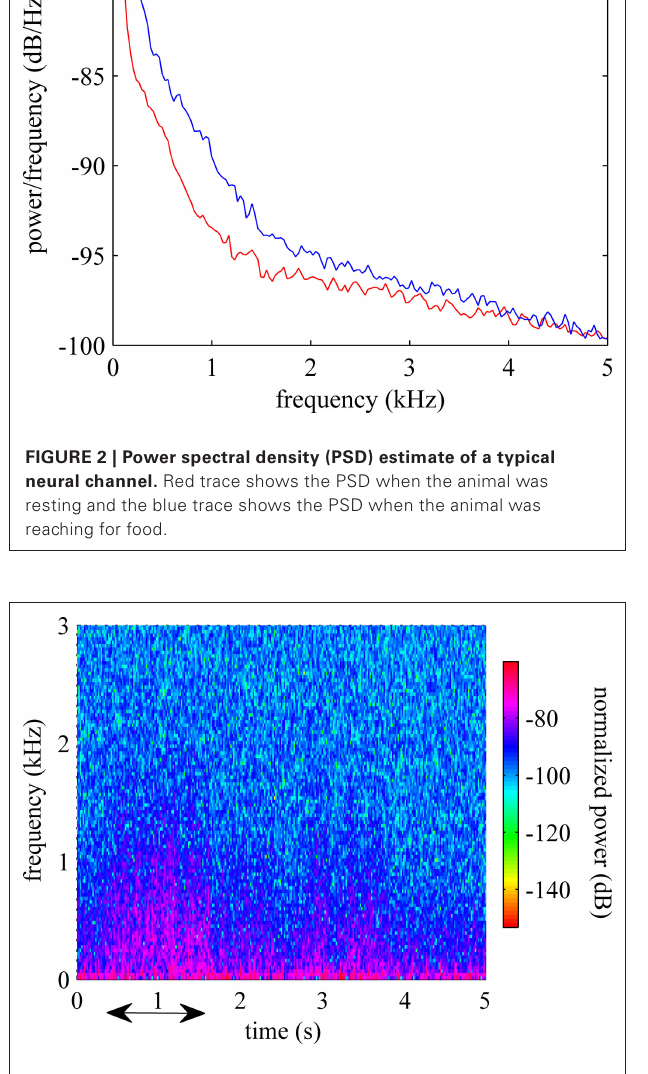
Figure 3 | Spectrogram estimated using Welch technique while the animal was performing the behavioral task. The arrow shows the duration of the behavior.